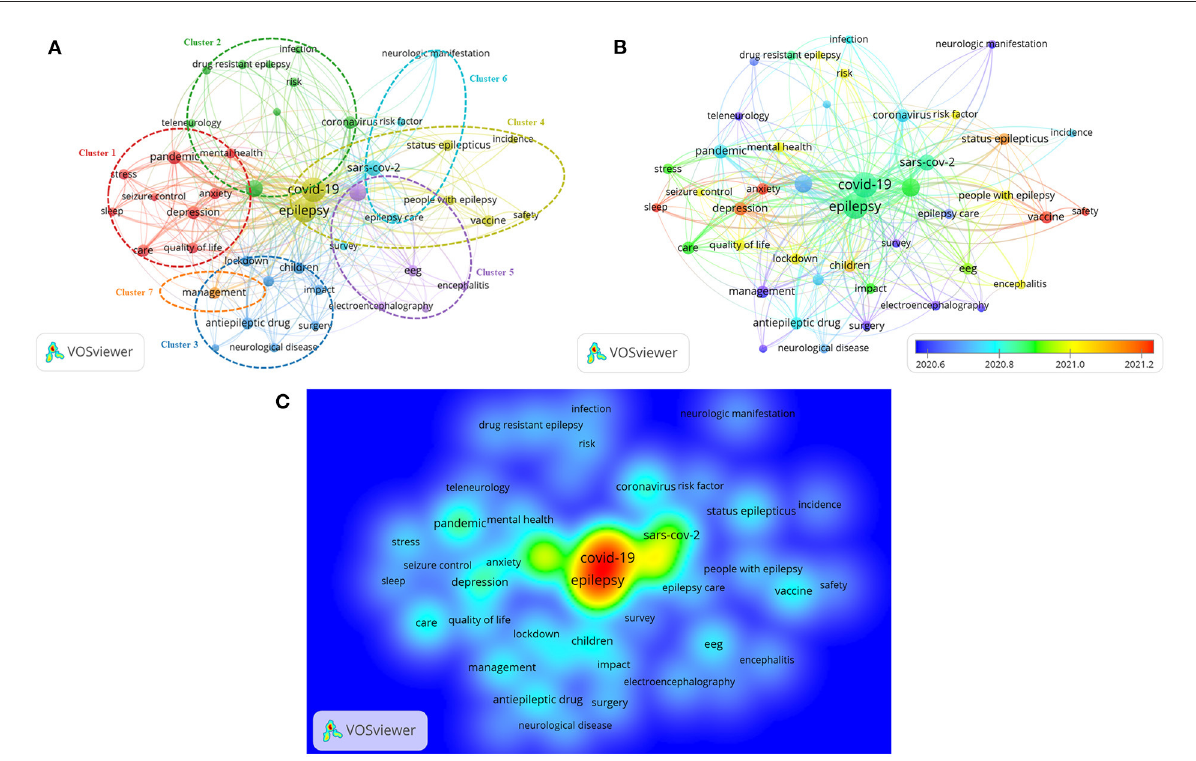
in red appeared the latest. (C) Density visualization map of keyword co-occurrence analysis. The map shows the distribution of keywords based on their average frequency of appearance. Keywords in red appeared most frequently, followed by those in yellow, green, cyan and